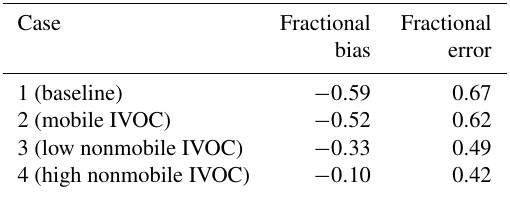
Table 5. Model OA performance metrics at all CSN sites (1 . 8 · OC) for this